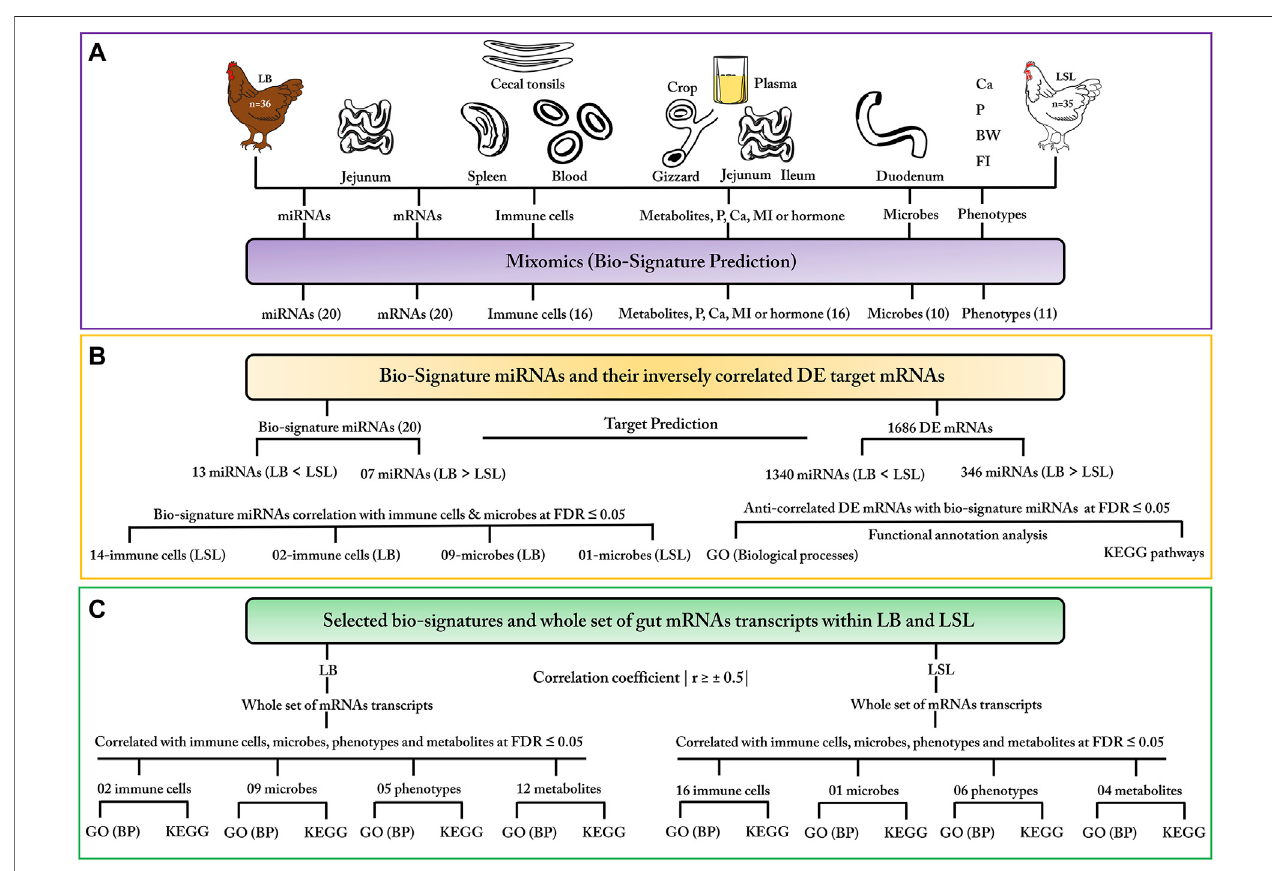
FIGURE 1 | Framework for multi-omics data integration and downstream analysis. (A) Data types: miRNAs, mRNAs, immune cells, microbes, blood/digesta parameters,and phenotypictraitsweremeasured from differenttissues,blood, and plasmaoftheLB and LSL layinghen strains. Discriminantanalysisin mixOmics was performed using the Sparse Partial Least Square Discriminant Analysis (SPLS-DA) supervised method for data classi fi cation and feature selection. The number of selected features in each dataset is given in brackets. (B) Pearson correlations between selected miRNAs and bio-signature of immune cells and microbes